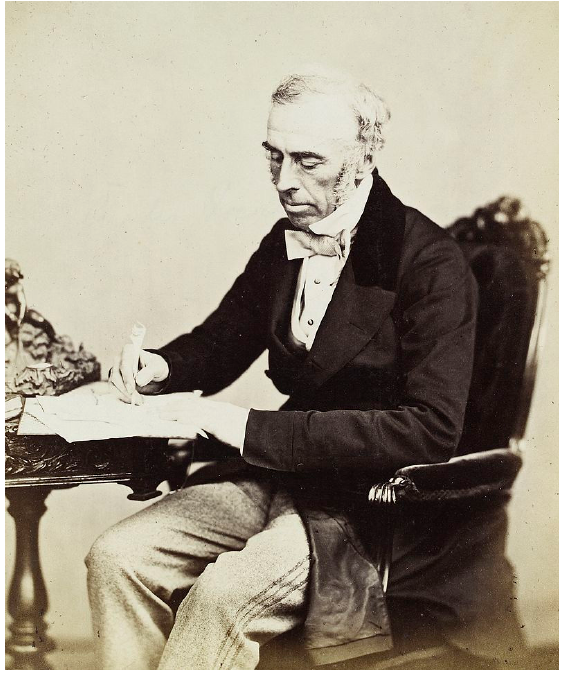
Figure 2. Portrait of Sir Charles Locock (1799–1875) dated 1862. Locock was an obstetrician, First Physician Accoucheur to the Queen Victoria and a member of the St. Albans Medical Club.